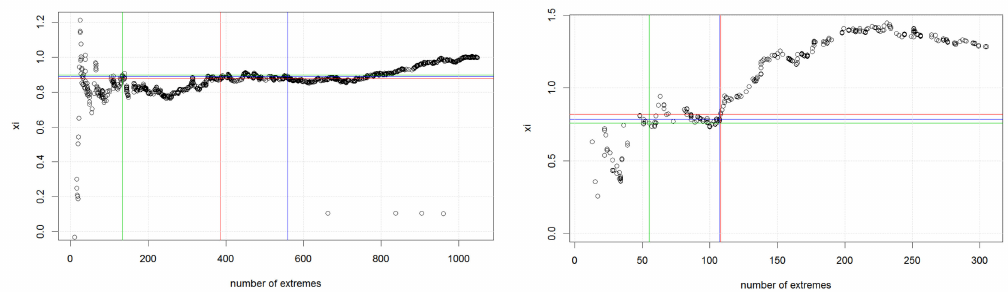
Figure A4. Plots of ξ for di ff erent thresholds (against the number of extremes used) for Styria( left ) and Salzburg ( right ) with the estimate for the 95% threshold (red), 98% threshold (green) and the chosen threshold (blue).